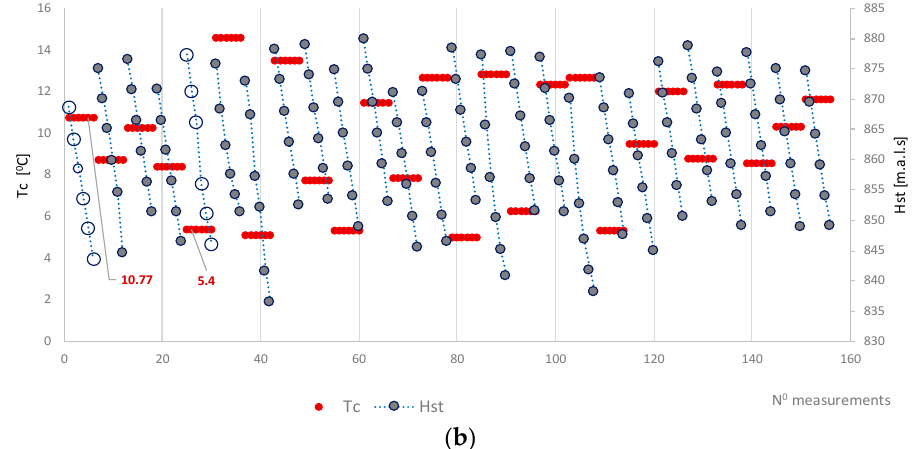
Figure 9. Aggregate effect of regressors in the model of total water losses in HT at PSHPP “Bajina Bašta” for the period 2005–2015, grouped by their physical context ( a ) and measurement values of predictors Tc and Hst ( b ).